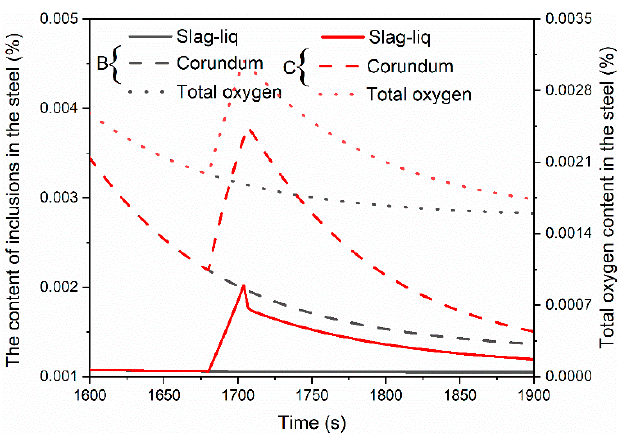
Figure 10. The influence of FeTi addition (1680 s) on the content of inclusions and O tot . Table 3. The mean composition of inclusion phases in simulations B and C.